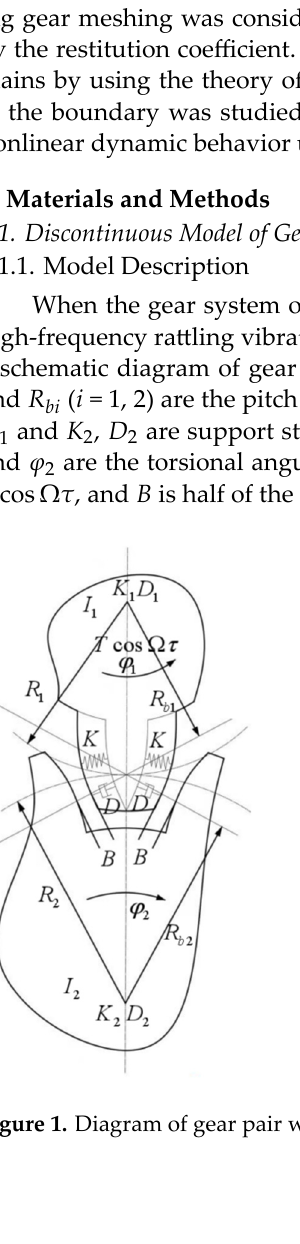
(2) Figure 2. Vibration-impact model of gear tooth with clearance.